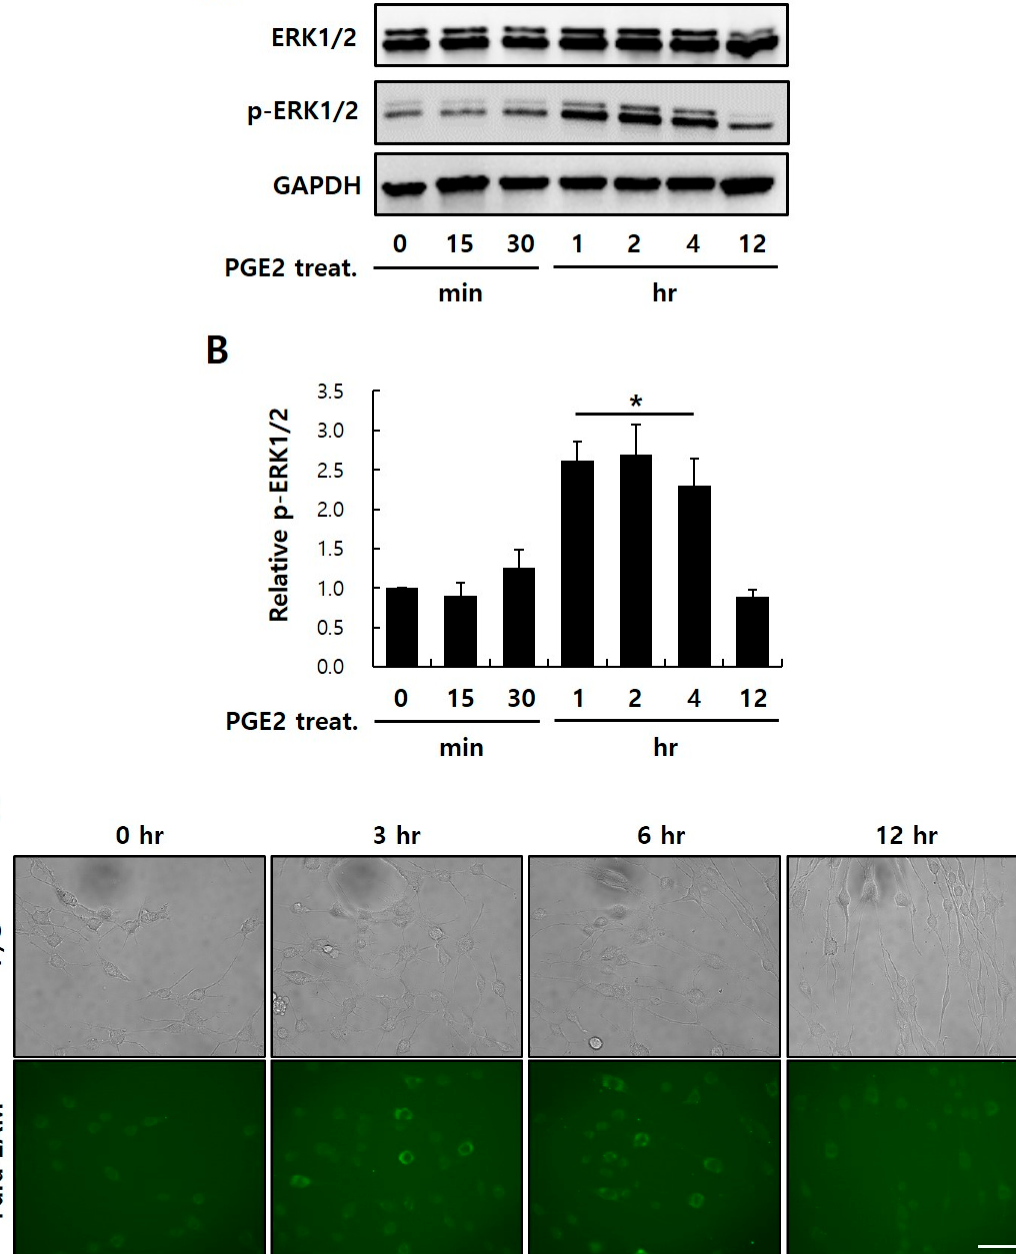
Figure 5. Determining the signaling pathway regulating PGE2–EP1 interaction in NHDFs. ( A ) Immunoblotting analysis for proteins associated with the mitogen-activated protein kinase (MAPK) signaling pathway. NHDFs were treated with 50 μ g/mL of PGE2 for various time courses. ( B ) Relative intensity values for p-extracellular signal–regulated kinase (ERK)1/2 were densiometrically quantified using Multi-Gauge V3.0 (Fujifilm Inc., Japan). Glyceraldehyde 3-phosphate dehydrogenase (GAPDH) was used to normalize variation in protein quantities from different samples. ( C ) Effects of PGE2 on the increase in intracellular Ca 2+ concentration in a time-dependent manner in NHDFs, as measured by immunocytochemistry, where 2 uM Fura-2AM was used as an indicator of cytoplasmic Ca 2+ (× 200). Results are the mean ± SD of three independent experiments. * p < 0.05 compared to the control. Scale bar: 30 μ m I also examined the effect of PGE2 treatment on intracellular Ca 2+ levels using Fura-2- acetoxymethyl (Fura-2AM), a membrane-penetrating radiometric fluorescent indicator used for Ca 2+ imaging by fluorescence. Inside the cells, the acetoxymethyl groups in Fura-2AM are removed by